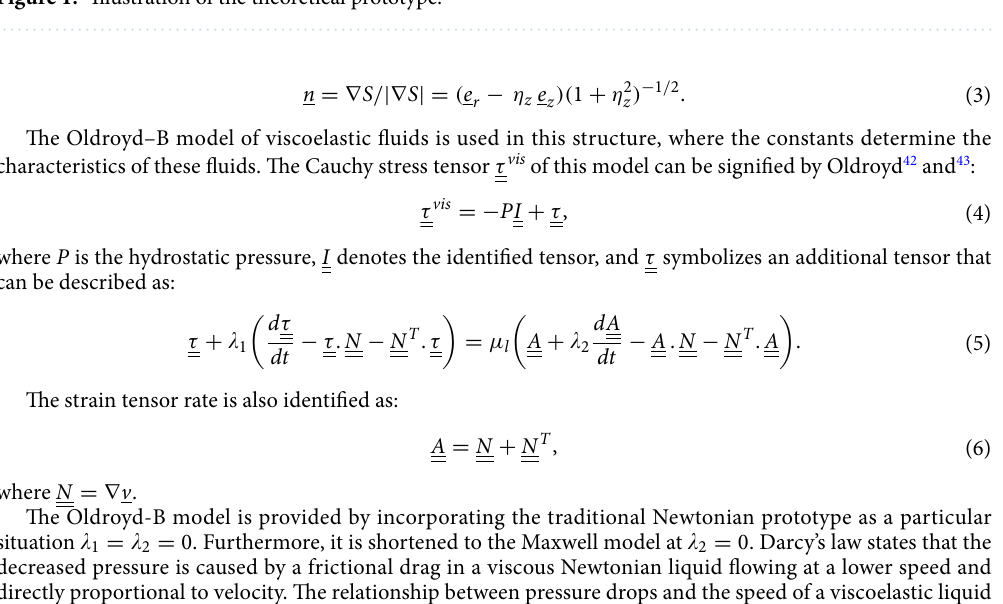
Figure 1. Illustration of the theoretical